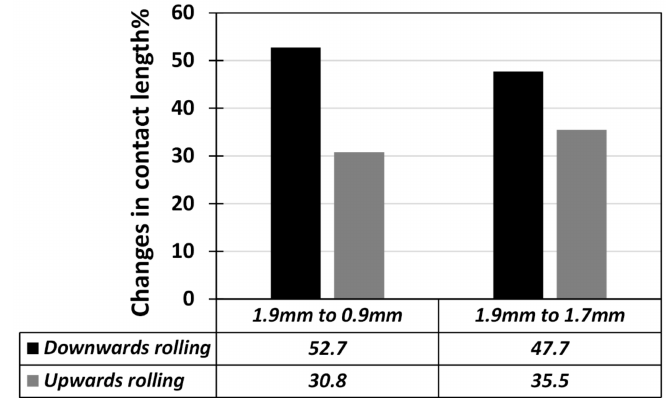
Figure 10. Effect of thickness reduction on the changes in the contact